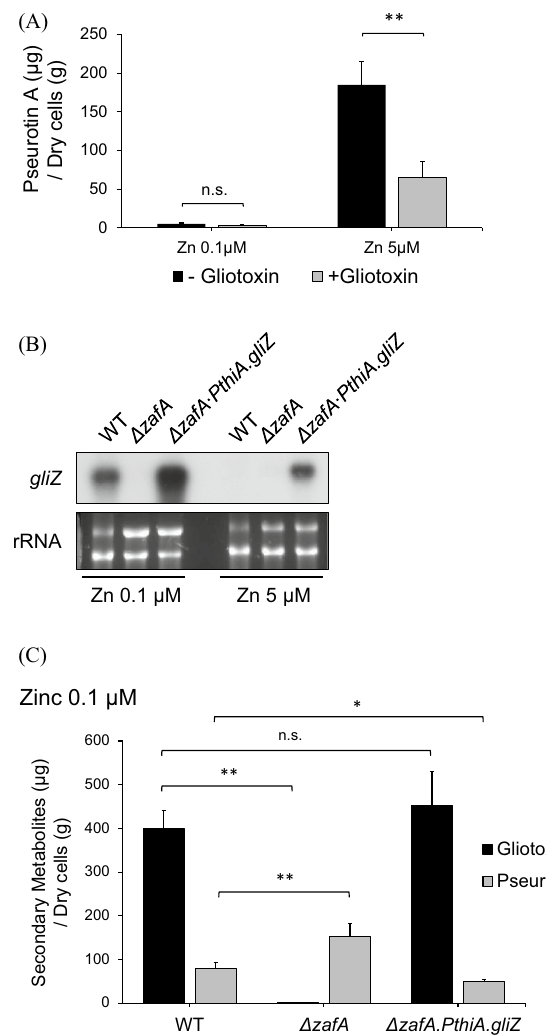
Figure 5. Pseurotin A biosynthesis was regulated by gliotoxin, and ZafA regulated pseurotin A biosynthesis through GliZ. ( A ) For identification of the effect of gliotoxin on pseurotin A biosynthesis, gliotoxin was directly added to the culture media, and pseurotin A was measured. The effect of gliotoxin on pseurotin A biosynthesis was measured under low (0.1 μM) and high zinc (5 μM) conditions. The black and gray columns indicate gliotoxin and pseurotin A, respectively. ns Not statistically significant, ** p < 0.01 indicates a significant difference compared to the control group. ( B ) For confirmation of the relationship between ZafA and GliZ in pseurotin A biosynthesis, constitutively gliZ -expressing cells with the thiA promoter in the zafA deletion mutant were constructed (Supplementary Fig. S2), and the expression of gliZ was confirmed under low (0.1 μM) and high zinc (5 μM) concentrations by northern blotting. The indicated cells were cultured in Czapek-Dox media, and total RNA was extracted from the indicated cells. (C) The amounts of pseurotin A produced in the wild-type, Δ zafA, and Δ zafA∙PthiA.gliZ strains were measured. ns Not statistically significant, * p < 0.05 and ** p < 0.01 indicate a significant difference compared to the control